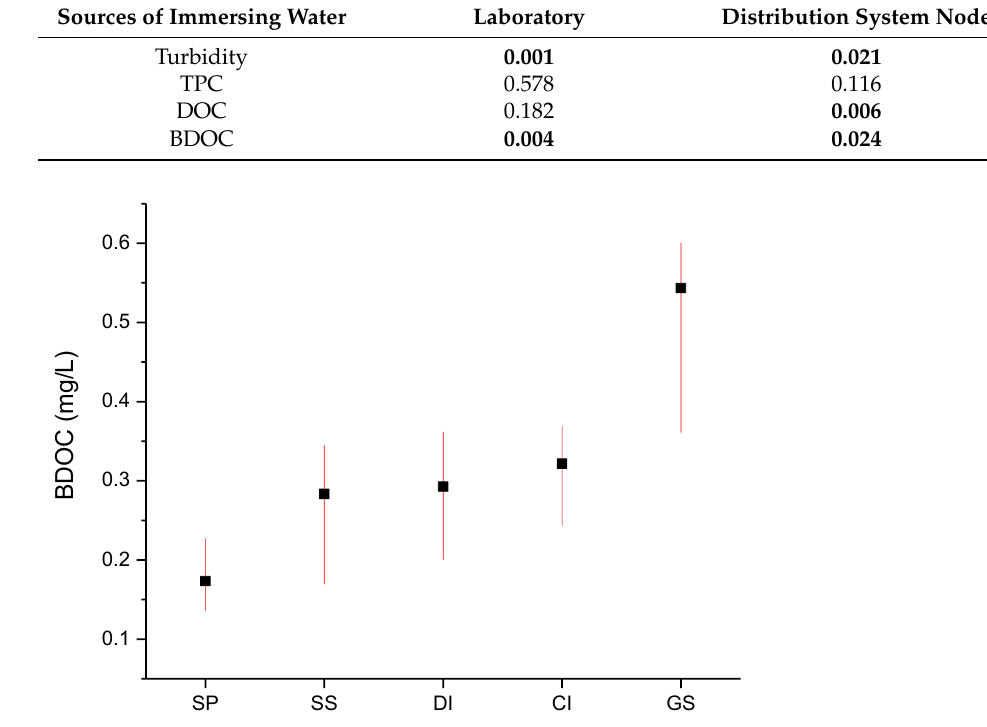
Effects of pipe materials on water quality in water from different sources using Kruskal–Wallis ANOVA. Factors with a p -value smaller than 0.05 are highlighted in bold. Sources of Immersing Water